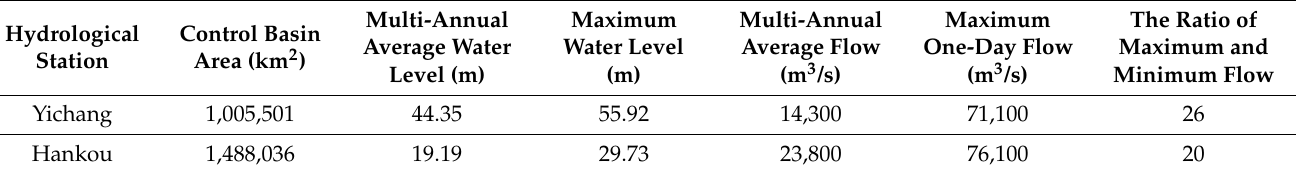
Table 1. Detail information of two hydrological